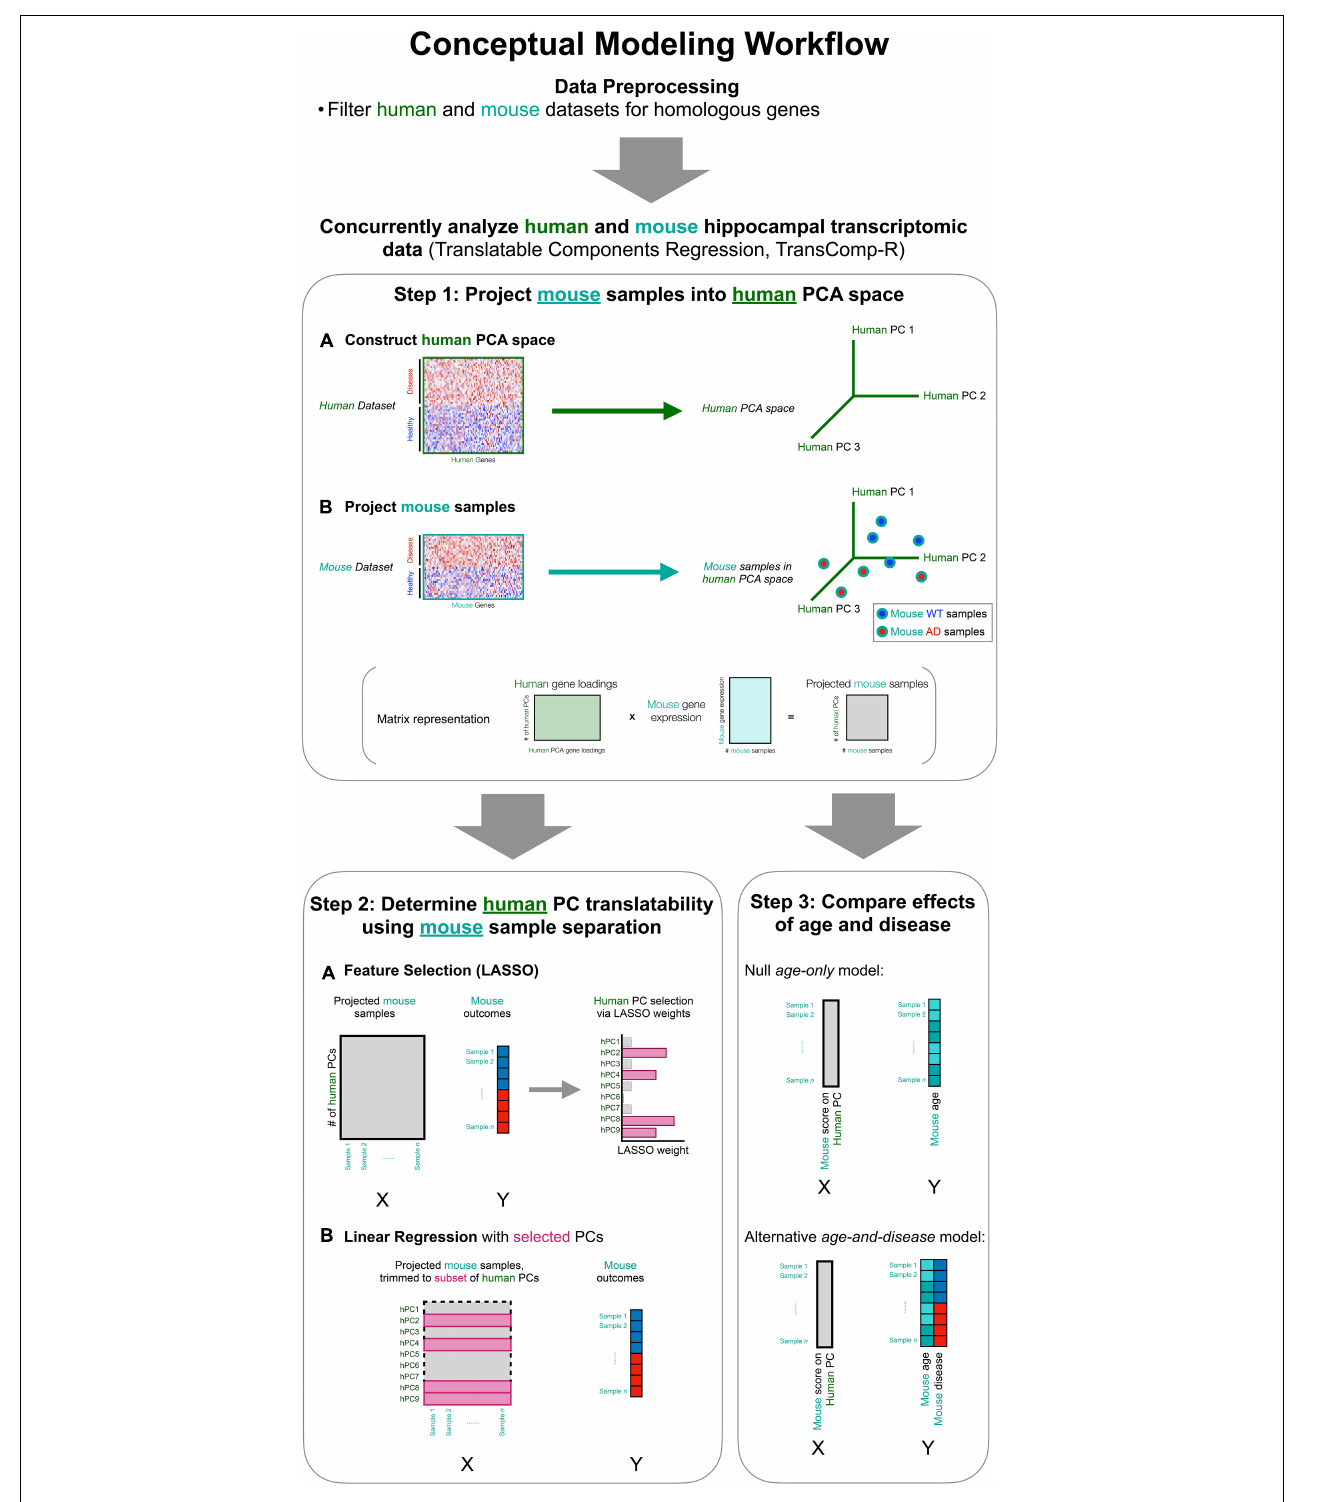
FIGURE 1 | Interspecies translation modeling identifies synergistic molecular signatures that are important in both human and mouse model datasets. The data are pre-processed for normalization and matching of cross-species homologs. The mouse and human data are then combined in a two-step process, which is a modified version of Translatable Components Regression (TransComp-R; Step 1, Step 2). Lastly, the combined data are evaluated to discern the effects of mouse age from mouse disease state (Step 3).